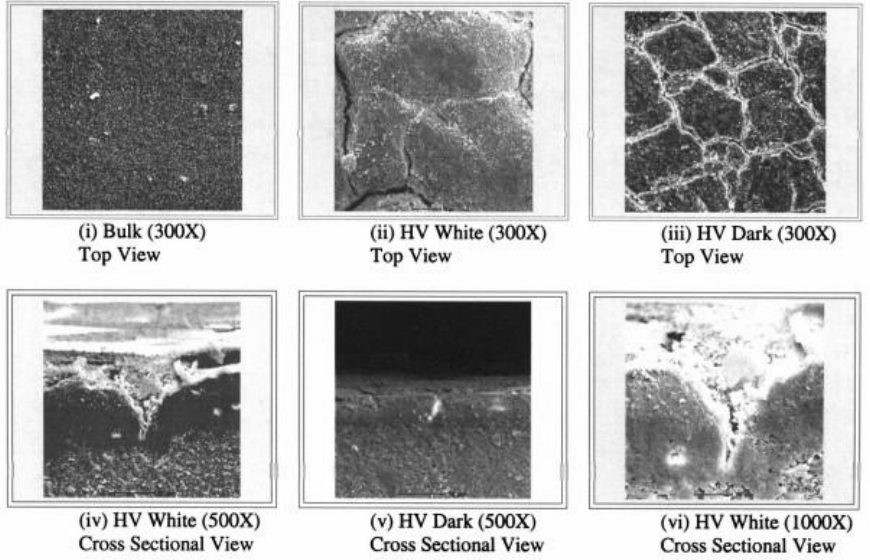
Figure 5. SEM images of the surface morphology changes of 345 kV EPDM insulators removed from service after 5 years in a coastal environment [34].